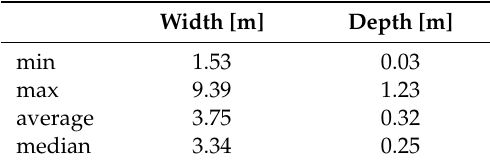
Table 4. Current state of the Pr ą dnik River—width and depth.